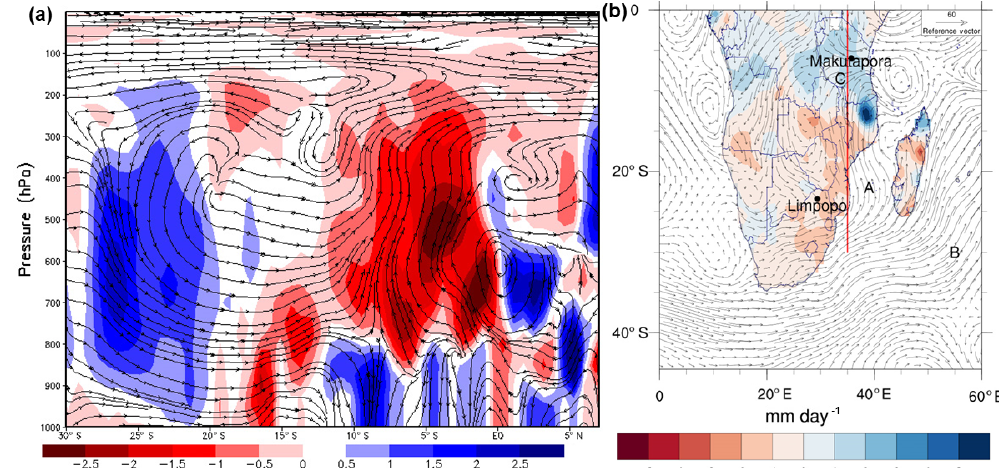
Figure 2. Circulation anomalies for October–April 2015–2016. (a) Latitude versus height transect plot of anomalous meridional overturning circulation (streamlines of vertical and meridional wind) and vertical velocity anomalies (ms − 1 ; shaded) averaged over the 35–37 ◦ E. This latitude transect is shown as a red line on the map in (b) . (b) Vertically integrated moisture flux anomalies (gkg − 1 ms − 2 ; vectors) and rainfall anomalies (mmday − 1 ;